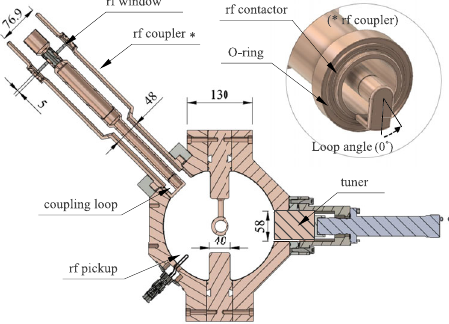
FIG. 7. Cross-sectional view of the short IH. The tuners have no rf contactors to simplify the structure.